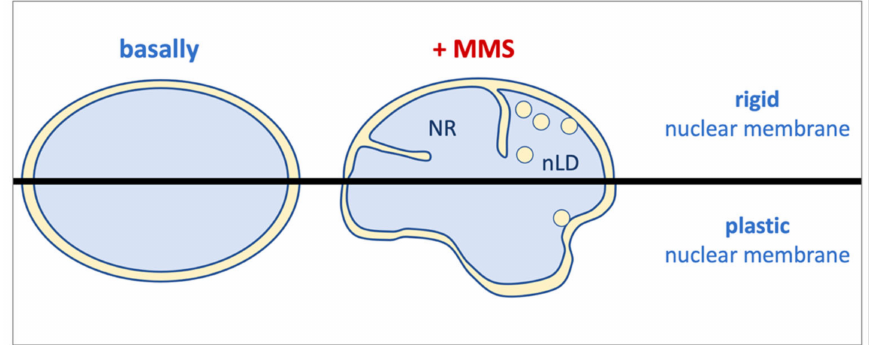
Figure 4. Model. Under basal conditions, nuclei display their ellipsoidal shape as ruled by their shielding membrane. Upon MMS treatment, a lipid stress is elicited at the inner nuclear membrane whose outcome is determined by the plasticity of such membrane. This way, in rigid contexts, such as in RPE-1 cells, the resistance of the membrane is alleviated by the emission of bodies toward the nucleoplasm, such as nuclear lipid droplets (nLD) and nucleoplasmic reticulum arms (NR). By contrast, in malleable scenarios such as in HepG2 cells, the membrane mostly responds by suffering an expansion, probably due to increased phospholipid synthesis, which makes it adopt a flower-like shape. Eventually, it can also emit nLD, albeit more